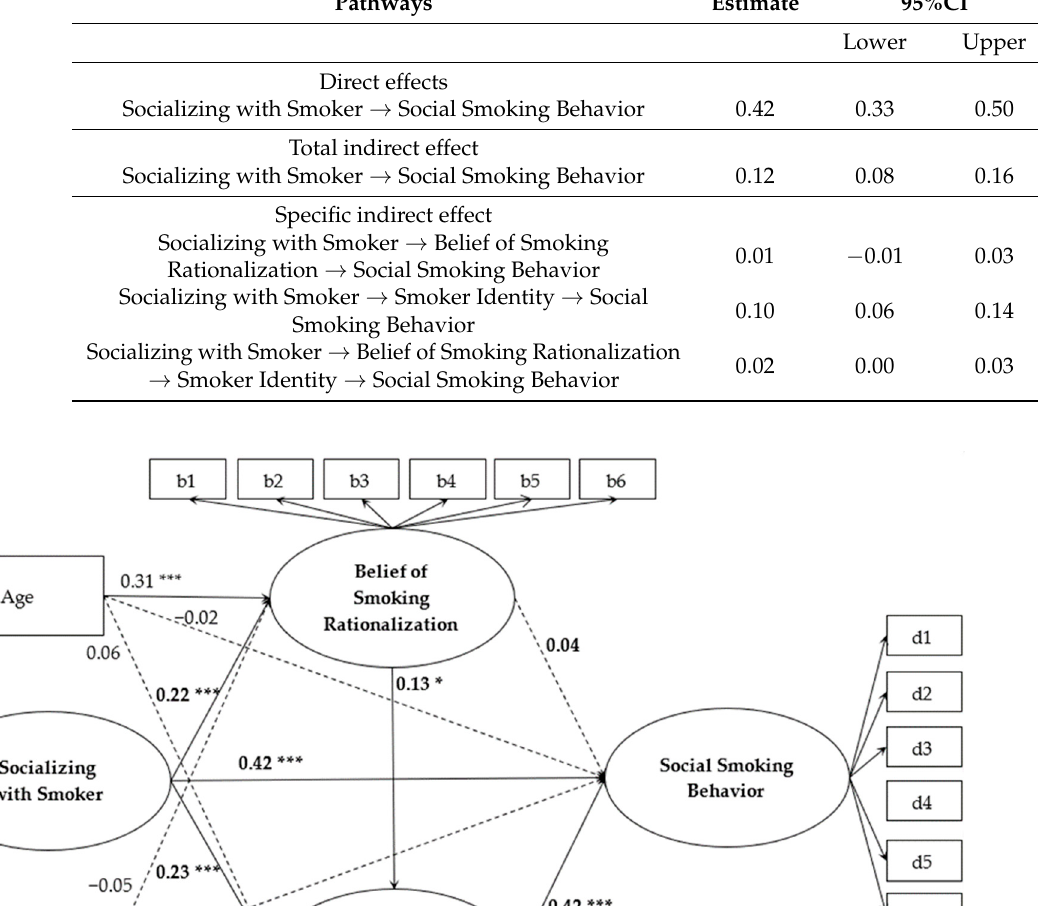
Table 2. Standardized estimates and 95% CIs for direct and indirect effects.